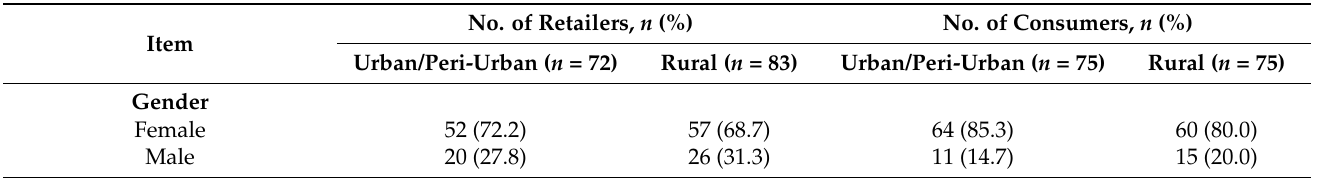
Table 1. Demographic characteristics of animal source food (ASF) retailers and